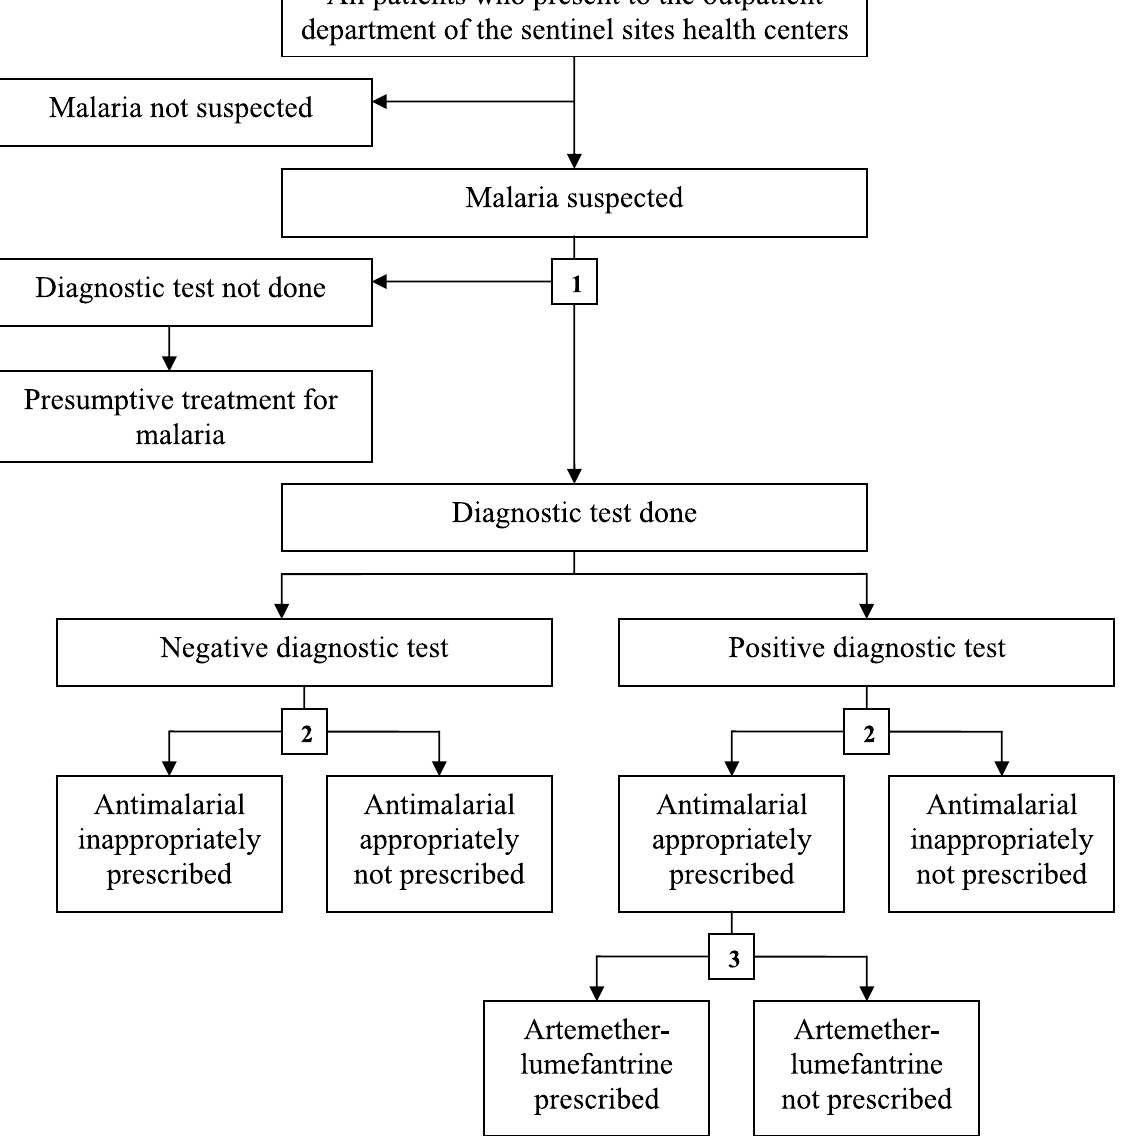
Figure 2. Malaria case management decision algorithm. Numbers highlight the three key indicators of malaria case management evaluated.